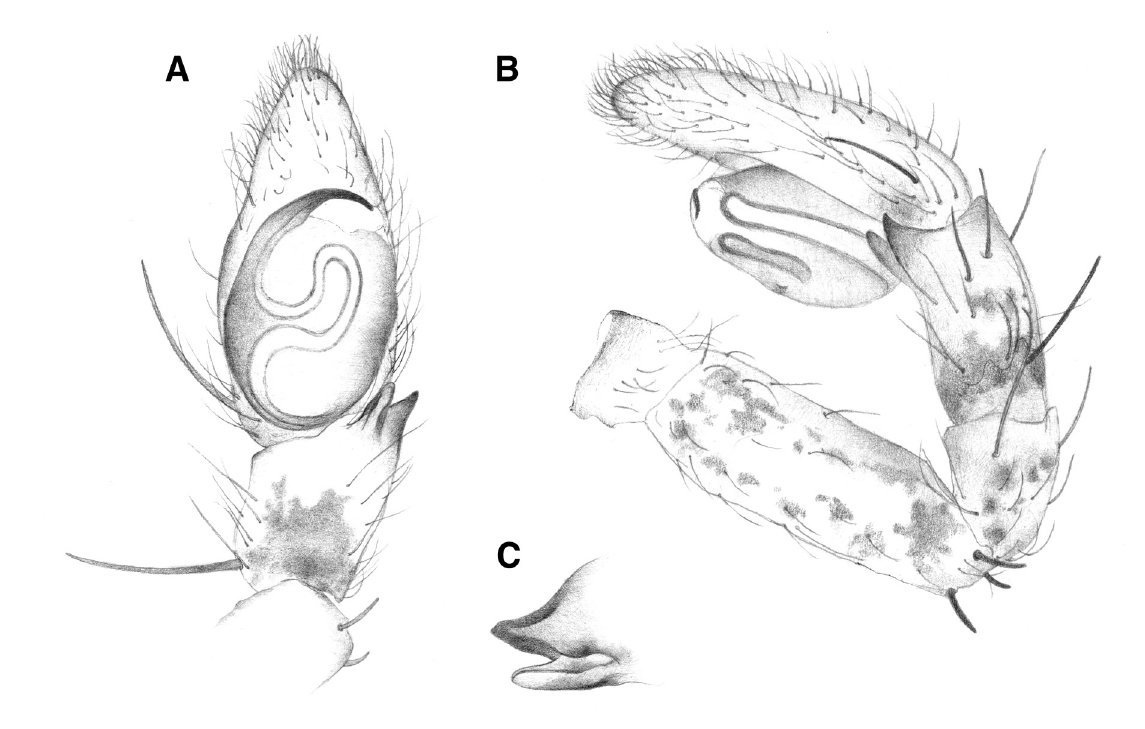
Fig. 6. Apollophanes fitzroyi sp. nov. A . ♂ palp, ventral view. B . ♂ palp, retrolateral view. C . ♂ palp, tibial